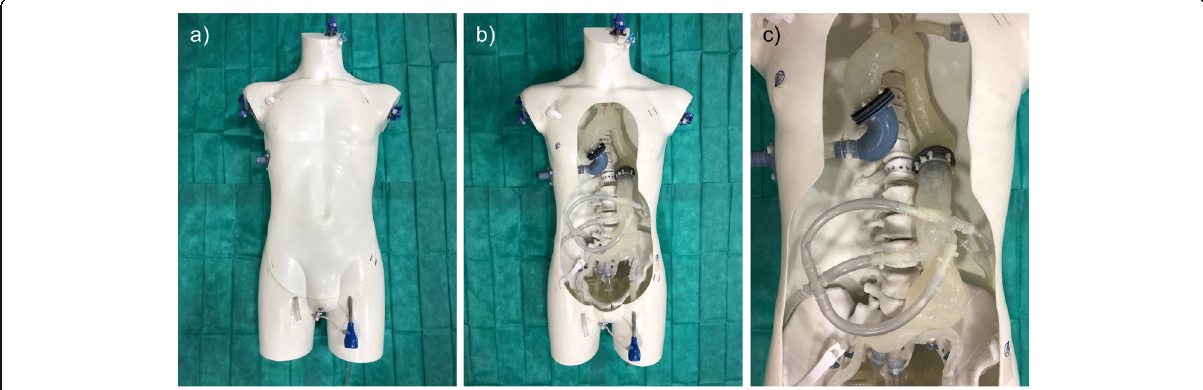
Fig. 1 Depiction of the true-to-life body phantom: a with cover; b without the cover; and c a close-up of the vasculature. The phantom was derived from a CT angiography dataset of a female patient suffering from an infrarenal aortic aneurysm. The skeleton was manufactured using 3D printing that was equipped with radiopaque coating. Vessel entry was possible via removable sluices in the communal femoral arteries, the ascending aorta and the supra-aortic